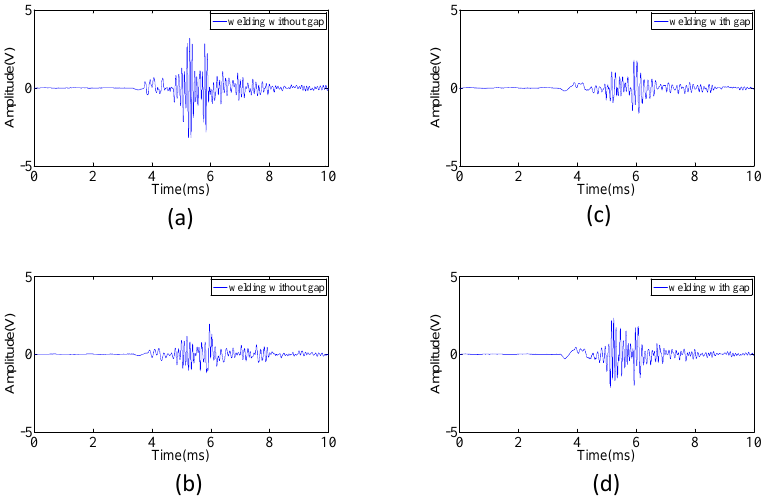
Figure 6. Sound signals collected during laser microlap welding: ( a ) normal joint strength—Nsample 1; ( b ) normal joint strength—Nsample 2; ( c ) low joint strength—Lsample 1; ( d ) low joint strength—Lsample